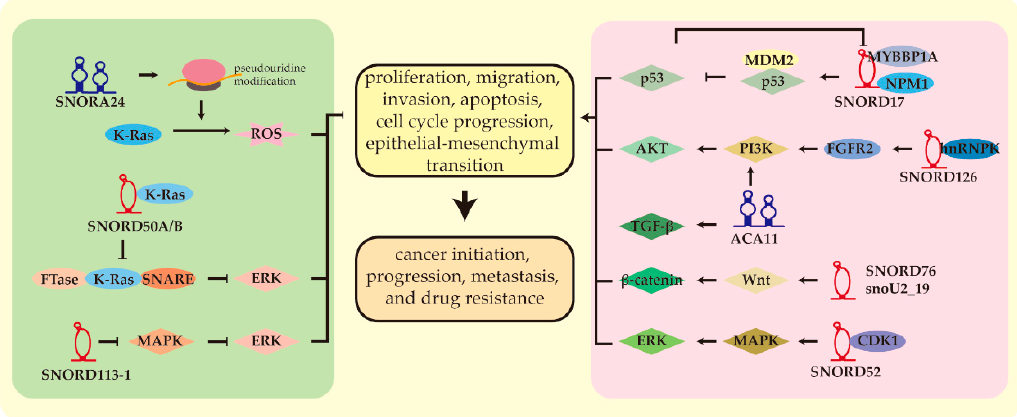
Figure 3. Mechanisms of snoRNAs in HCC. Abnormal expression of snoRNAs could lead to various pathophysiological changes. They could regulate a variety of signaling pathways by binding or releasing target proteins. Aberrant expression of snoRNAs in HCC could activate PI3K/AKT, Wnt/ β - catenin, TGF- β , MAPK/ERK pathways while inhibiting the p53 pathway. They played a critical role in cellular processes, including proliferation, migration, invasion, apoptosis, cell cycle progression, and epithelial-mesenchymal transition, which were critical for cancer initiation, progression, metastasis, and drug resistance.